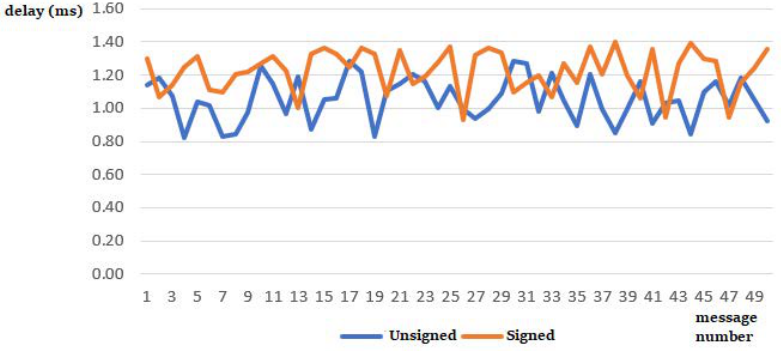
Figure 17. Transmission delay with security enabled and disabled.